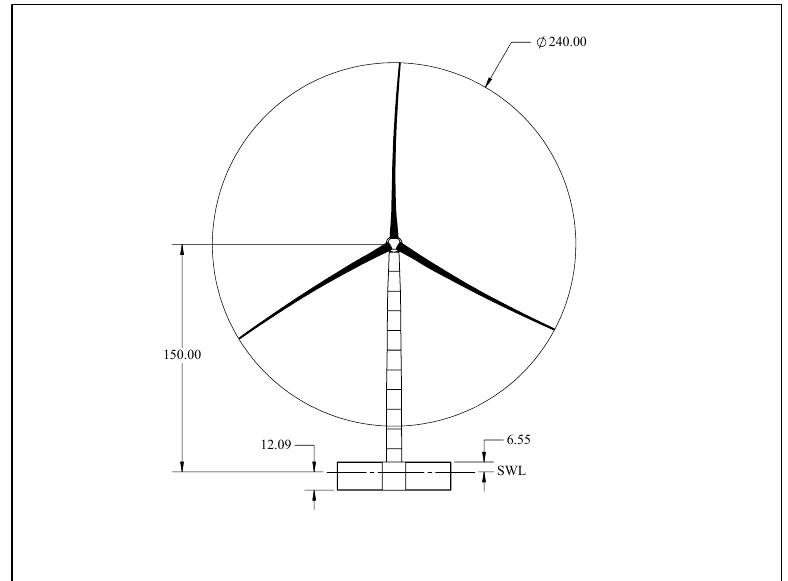
Figure 19. Drawing of the platform with IEA 15-MW turbine. A view of the platform showing the outer dimensions is shown in Figure 20.